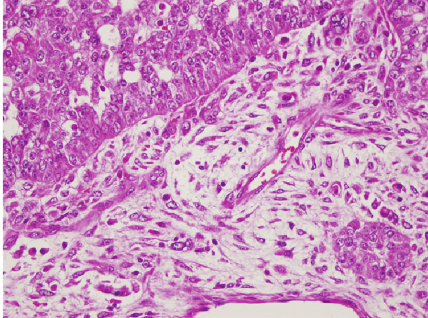
Figure 3: The transition zone between carcinoma and sarcoma components [HE ×